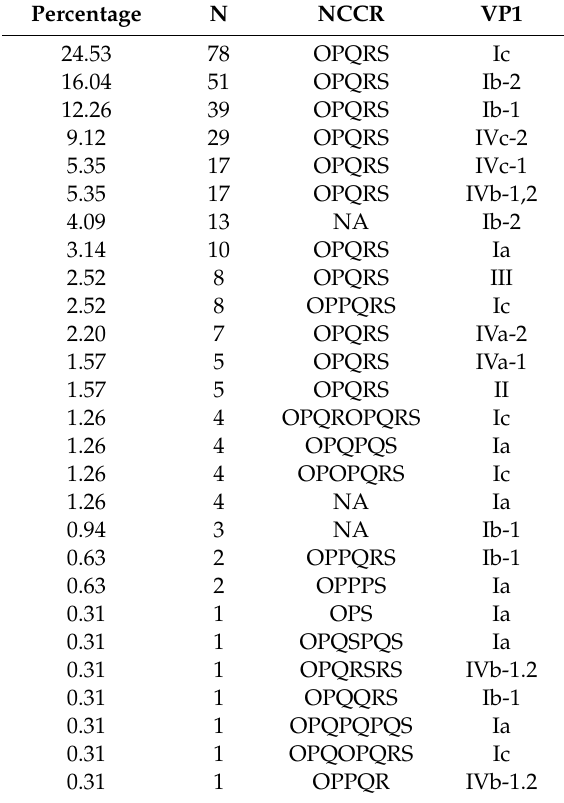
Table S1: List of NCBI accession number of BKPyV genome neighbors, Table S2: Complete BKPyV genotyping record of NCBI BKPyV genome neighbors until March